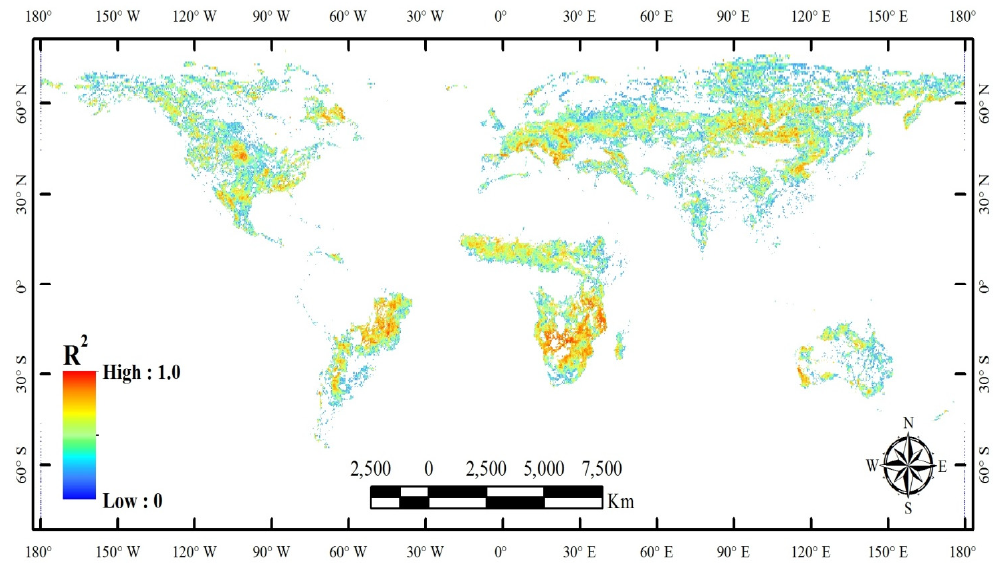
Figure 4. Global map of the coefficient of determination ( (cid:1844) (cid:2870) ) of the relationship between (cid:1853) ∗ and NDVI (AMSR-E observations at C-band, January 2010–September 2011), for the case (cid:1843) (cid:3404) 0 .